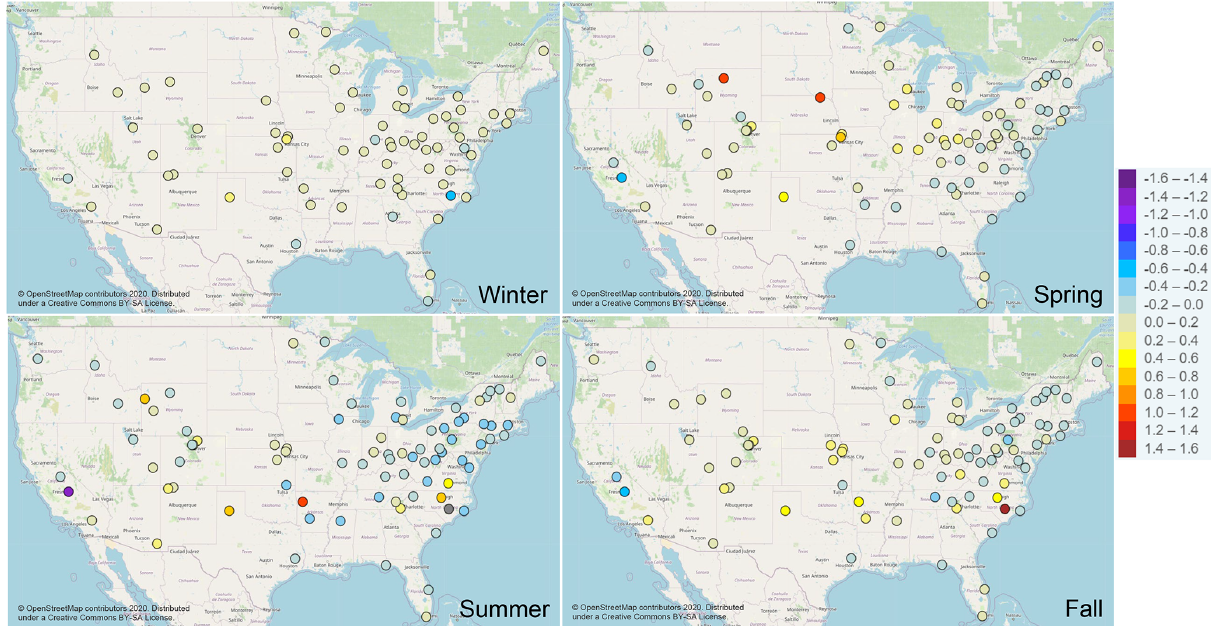
Figure 17. Seasonal average NH 3 absolute bias difference (µgm − 3 ) between CMAQ531_WRF411_M3Dry_BiDi and CMAQ531_WRF411_STAGE_BiDi simulations for all AMON sites. Cool shading (negative values) indicates smaller bias in the CMAQ531_WRF411_M3Dry_BiDi simulation, and warm colors (positive values) indicate smaller bias in the CMAQ531_WRF411_STAGE_BiDi simulation. Grey shading indicates values beyond the range of the